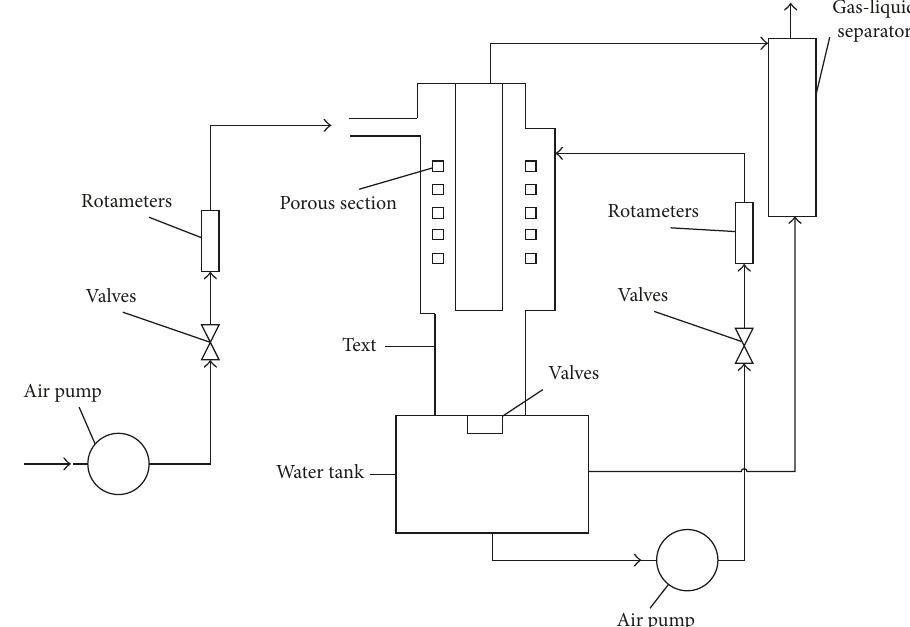
Figure 5: Water-sparged aerocyclone reactor